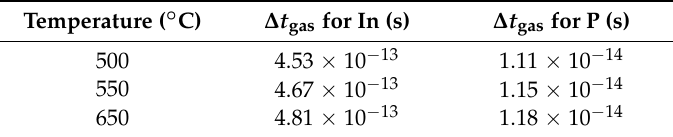
Table 2. Values of ∆ t gas for In and P obtained by Equation (15). Here, we assume that In and P pressures are 3.3 × 10 − 3 and 0.1 Torr, respectively.